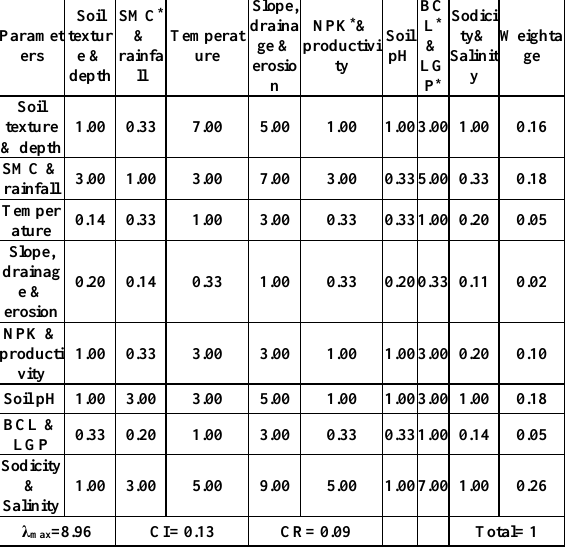
By using the above weightage in the weighted overlay tool in ArcGIS, Cereal crop suitability output has been generated. After the generation of output it has been mask out by land use land cover mask of Uttar Pradesh to exclude the non-agricultural region. And final cereal suitability map has been generated. The flow chart (fig: 3) represents the methodology followed in this